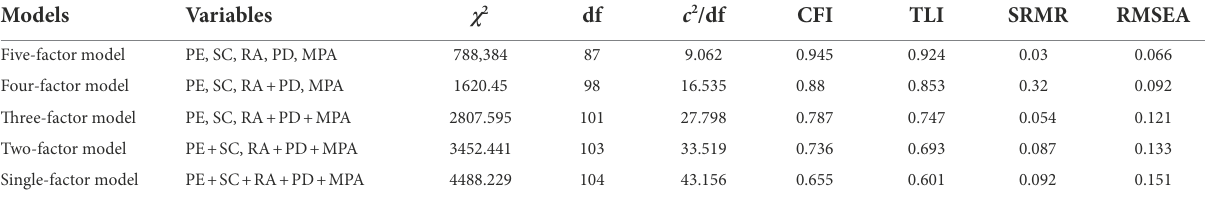
TABLE 1 Results of confirmatory factor analyses. Models